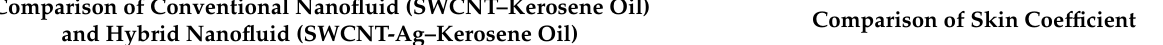
Table 4. Comparison of the obtained outcomes with previously published work.